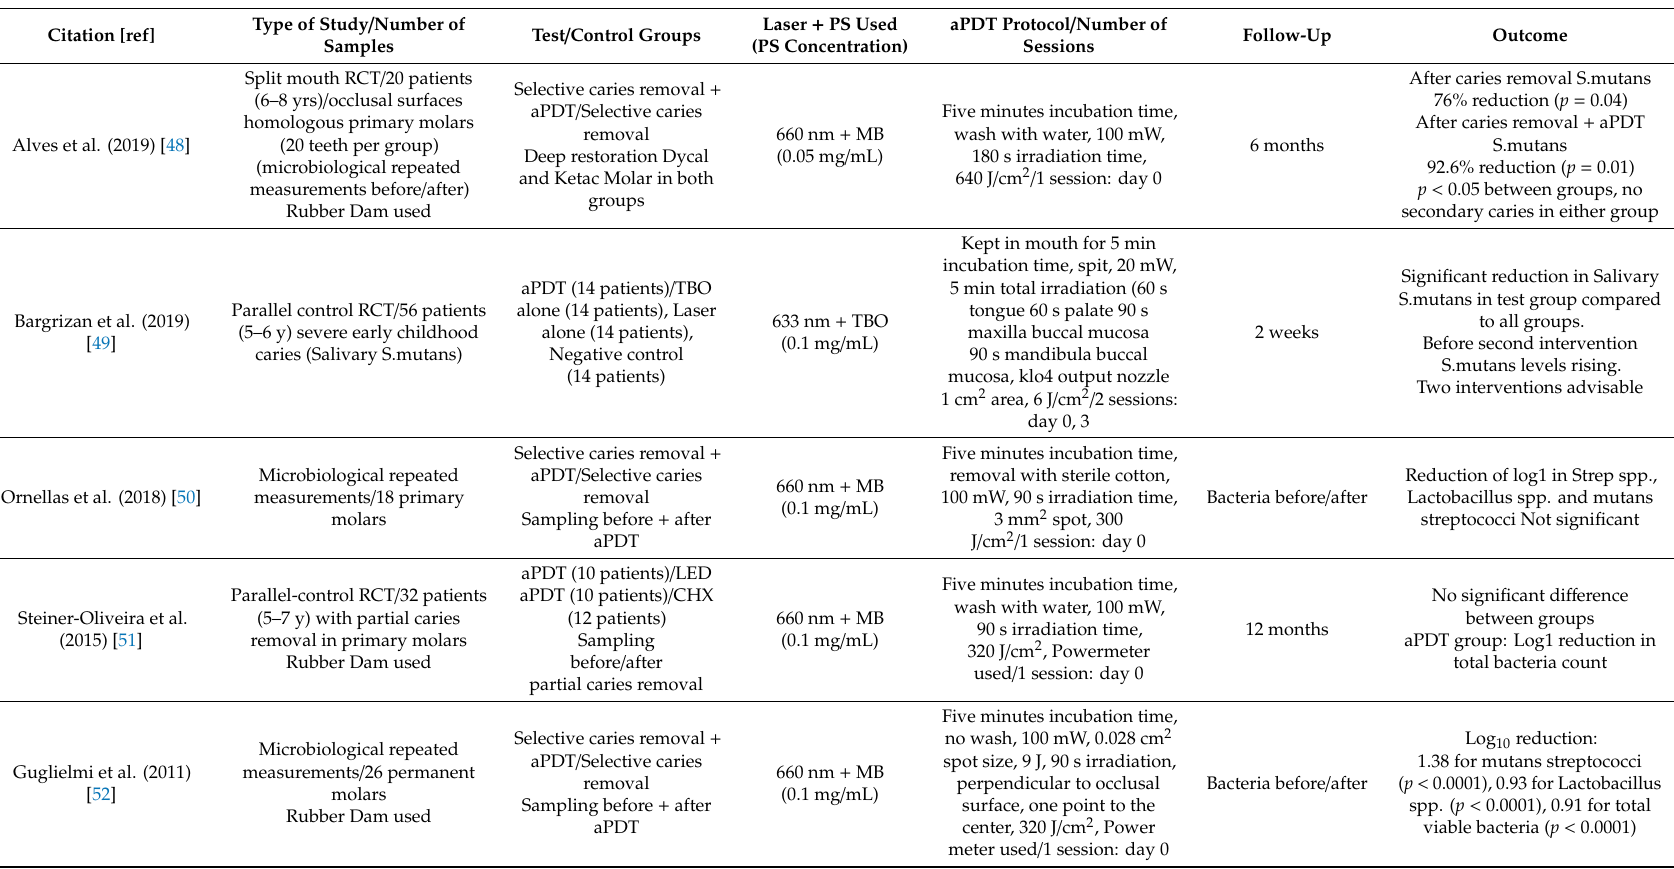
Table 4. Studies aPDT in caries